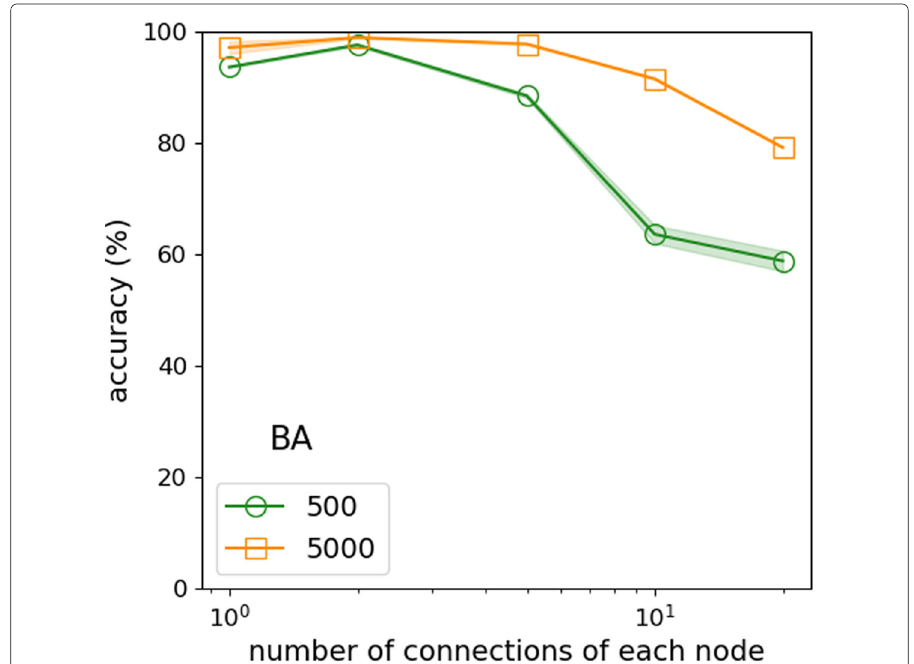
Fig. 6 Accuracy of reconstruction in BA networks under different number of connections of each node